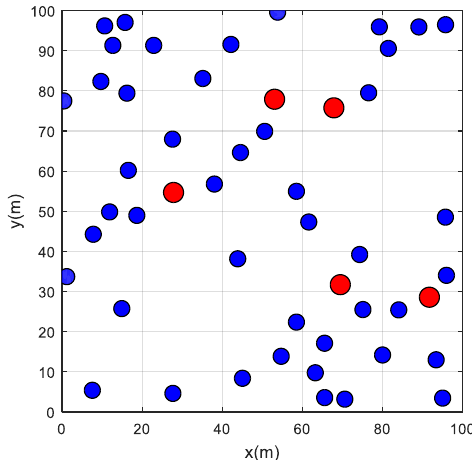
Figure 8. Plot of reference and target nodes for case 4.